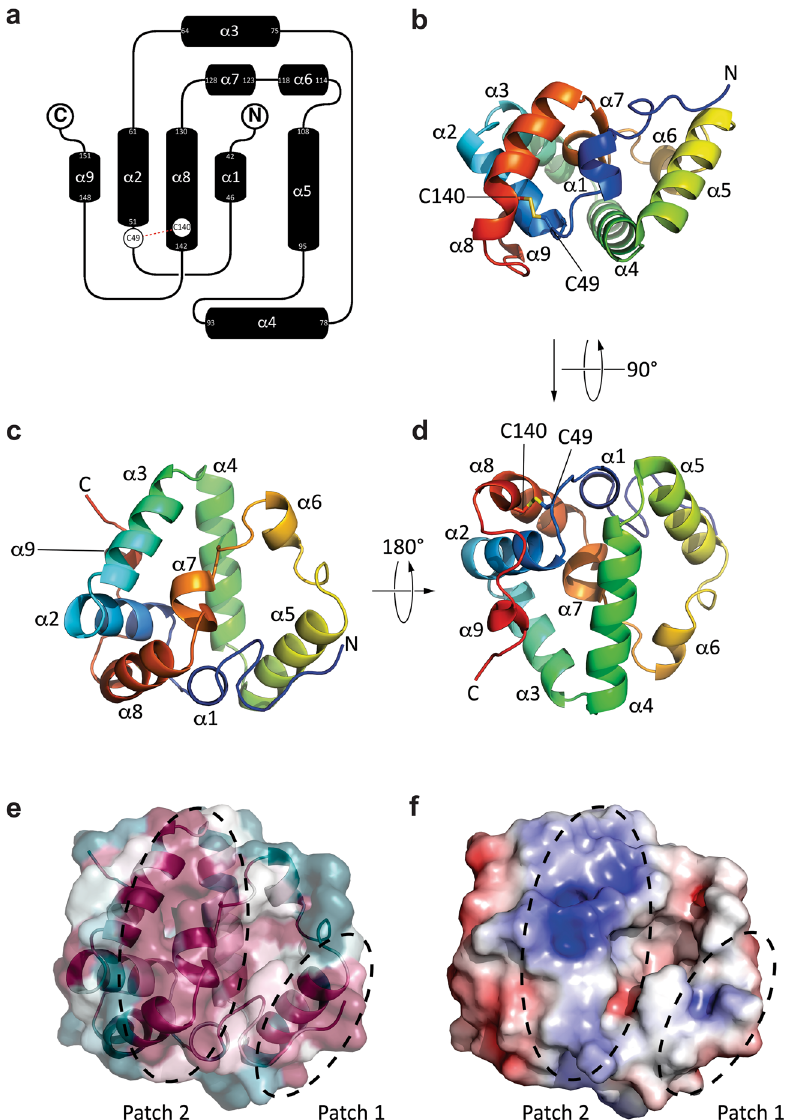
Fig. 5 Structure of the Rv0455c homolog MSMEG_3494. a Topology of MSMEG_3494 33-153 . N- and C-termini are indicated, helices are depicted as black tubes numbered from N-terminus to C-terminus ( α 1- α 9; other numbers represent the sequence number for the fi rst and last residue of the helix). The disul fi de bond between C49 and C140 is indicated with a red dashed line. Loops are not drawn to scale. b – d Cartoon depictions of MSMEG_3494 33-153 colored by amino acid sequence from the N-terminus (blue) to the C-terminus (red). The disul fi de bond between C49 and C140 is shown using stick representation and colored yellow. Spatial relationship between the orientations in b – d are re fl ected by the rotational arrows between each image. e Colors re fl ect the conservation of amino acids across the 150 closest members of DUF5078 to MSMEG_3494. Purple indicates high conservation, white indicates moderate conservation, and teal indicates a lack of conservation. Patches 1 and 2 are highlighted within black dashed ellipses. The orientation is the same as in ( c ). f Surface depiction of the electrostatic surface potential from -5 kT/e (red) to + 5 kT/e (blue). Patches 1 and 2 are highlighted within black dashed ellipses. The orientation is the same as in ( c